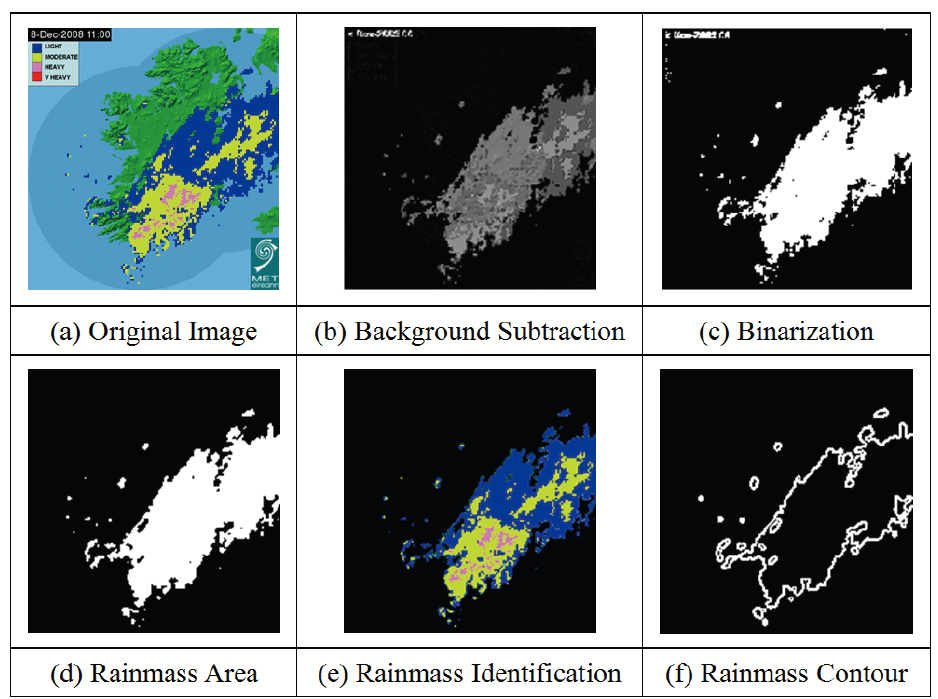
Figure 4. Rainfall Radar Image